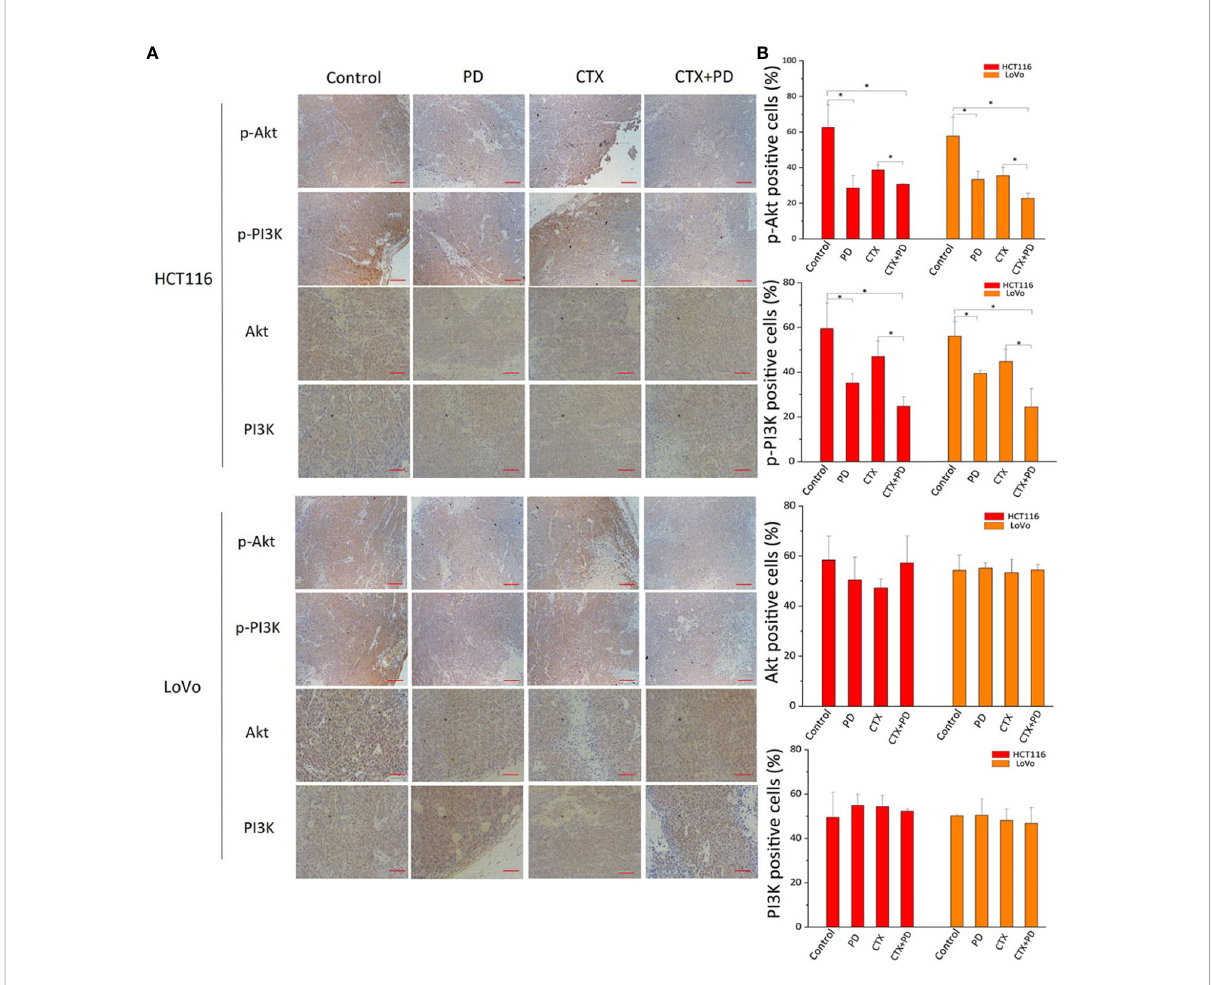
FIGURE 8 Immunohistochemical analysis of PI3K and Akt in tumor tissues treated with PD and/or CTX. (A) Images of immunohistochemically stained tissues. The left column shows proteins in each tumor type. The top row shows drug treatments with different combinations. Scale bars, 100 m m. (B) Quantitation of positive staining for p-Akt, p-PI3K, Akt, and PI3K in every group. Graph of percentage of positive cells for immunohistochemical staining (three random fi elds). ImageJ was used to quantify the positive immunohistochemical staining results (n=3). Data are shown as the mean ± S.D. One-way ANOVA was used to analyze P values between groups. All groups are compared with the ‘ Control ’ group, and the ‘ CTX ’ group is compared with the ‘ CTX+PD ’ group. * P < 0.05 represents a signi fi cant